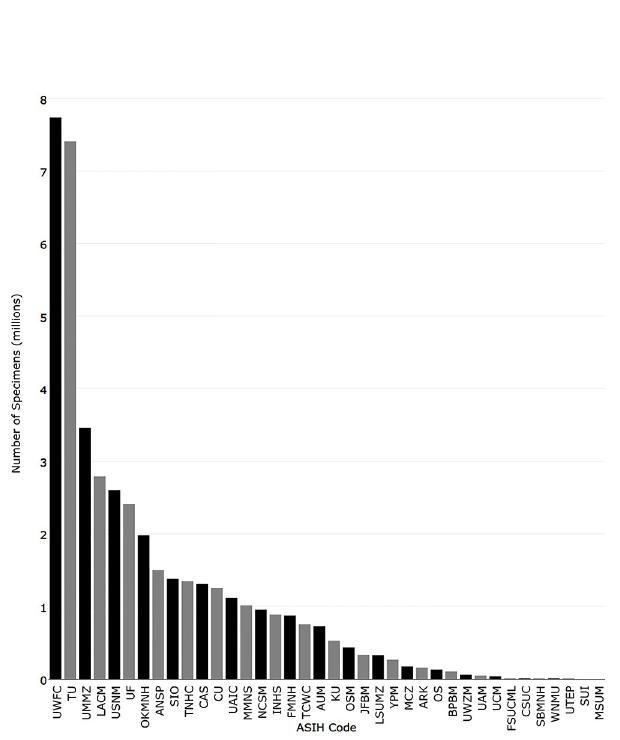
Fig 4. Number of individual specimens returned for the 38 fish collections with recordsets in iDigBio.